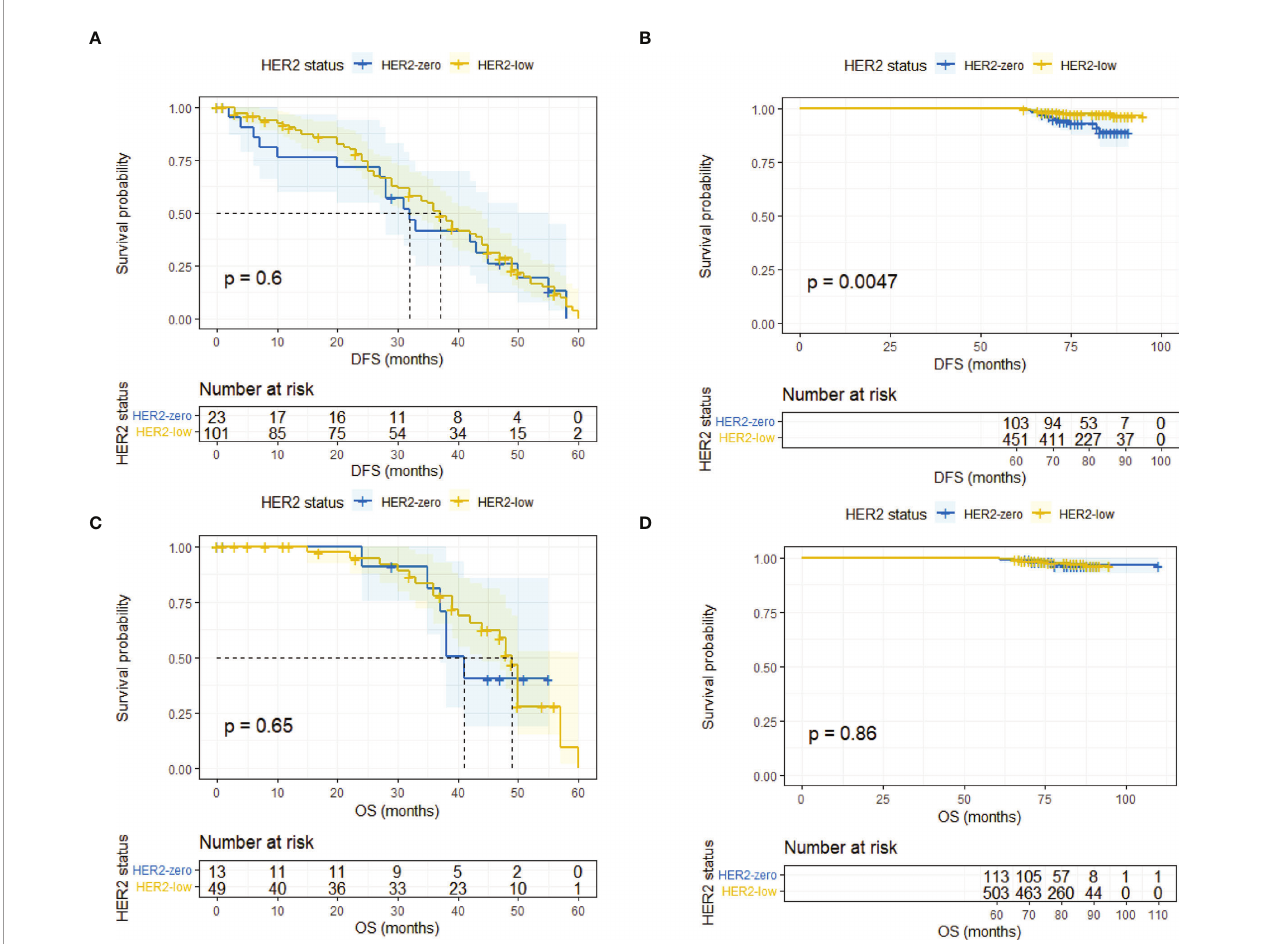
FIGURE 4 | Landmark analysis of DFS and OS in HR-positive/HER2-zero and HR-positive/HER2-low patients. (A) DFS in HR-positive/HER2-zero and HR-positive/ HER2-low patients within 60 months. (B) DFS in HR-positive/HER2-zero and HR-positive/HER2-low patients after 60 months. (C) OS in HR-positive/HER2-zero and HR-positive/HER2-low patients within 60 months. (D) OS in HR-positive/HER2-zero and HR-positive/HER2-low patients after 60